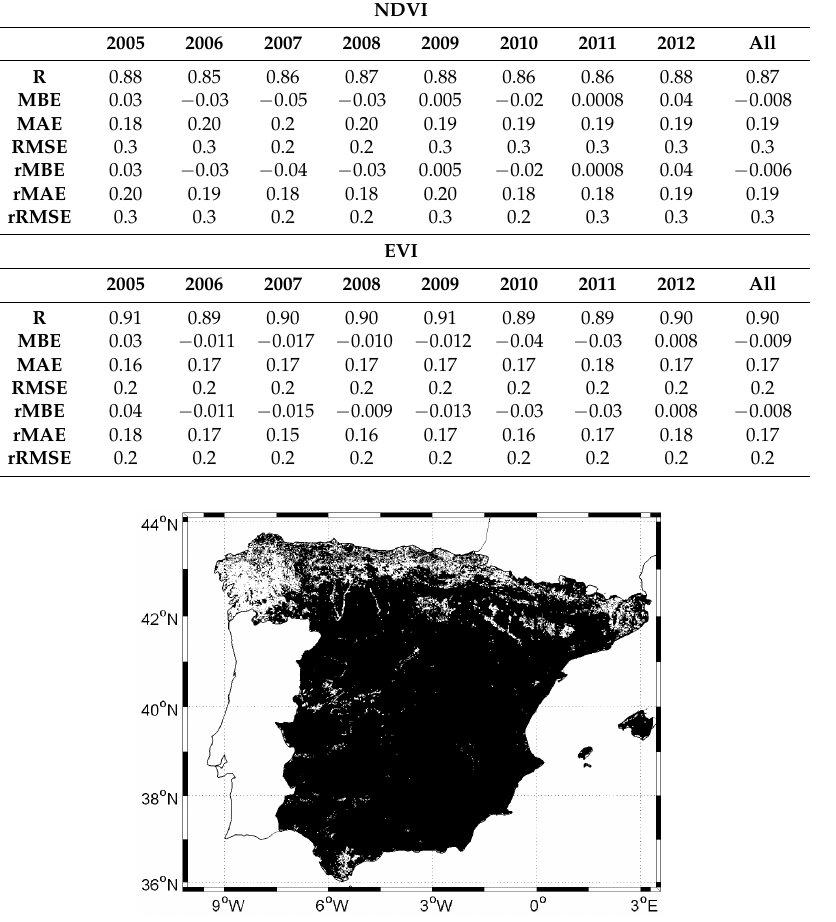
( d ) Figure 6. Mean rMBE (%) image showing the spatial distribution of the discrepancies between the estimated and the reference annual GPP: ( a ) Estimated annual GPP using the semi-empirical model with NDVI and with constant values of C 1 and C 2 ; and ( c ) considering C 1 and C 2 as a function of the land-cover type. ( b ) Estimated annual GPP using the semi-empirical model with EVI and with constant values of C 1 and C 2 ; and ( d ) considering C 1 and C 2 as a function of the land-cover type (red colors correspond to overestimates and blue color to underestimates). As mentioned above, Figure 6 shows average uncertainties for all the years when using the hybrid classification map. For the year 2011, the comparison between reference and estimated annual GPP data (Figure 7) shows a similar spatial pattern, although the model slightly underestimates GPP in highly productive areas corresponding to dense forests (Figure 5), more noticeable when using NDVI.